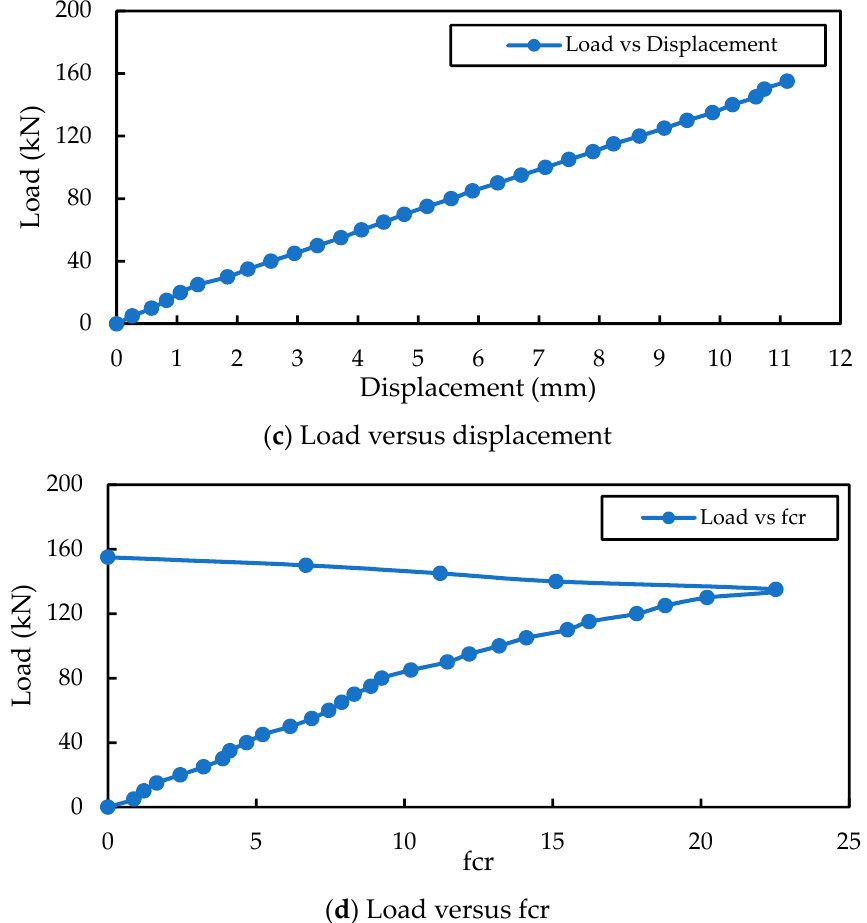
Figure 9. Graphical representation of ( a ) stress vs. strain, ( b ) fcr vs. strain, ( c ) load vs. displacement and ( d ) load versus fcr behaviour of brass fibre added mortar layer pasted on existing concrete beam with Araldite paste of length 1.5 m.